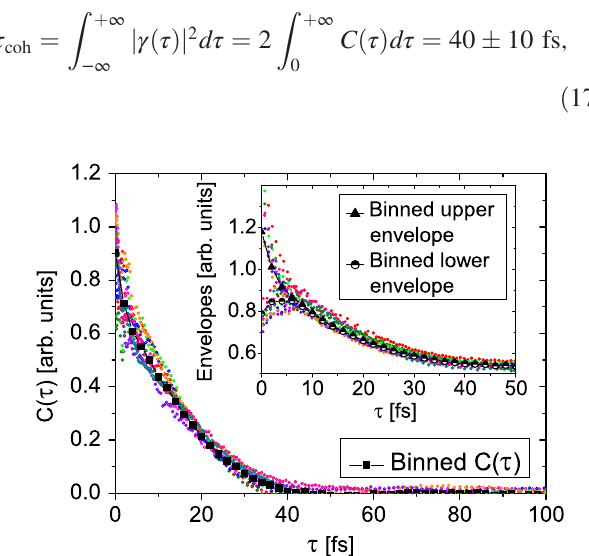
FIG. 13. Squared modulus of the radiation CDC as measured with the HNFS technique. Data from the different 9 sample- detector distances shown in Fig. 12 have been merged through Eq. (13) and binned. Inset shows the corresponding upper and lower envelopes. The tapering effect of the modified Talbot transfer function is clearly visible for τ < 10